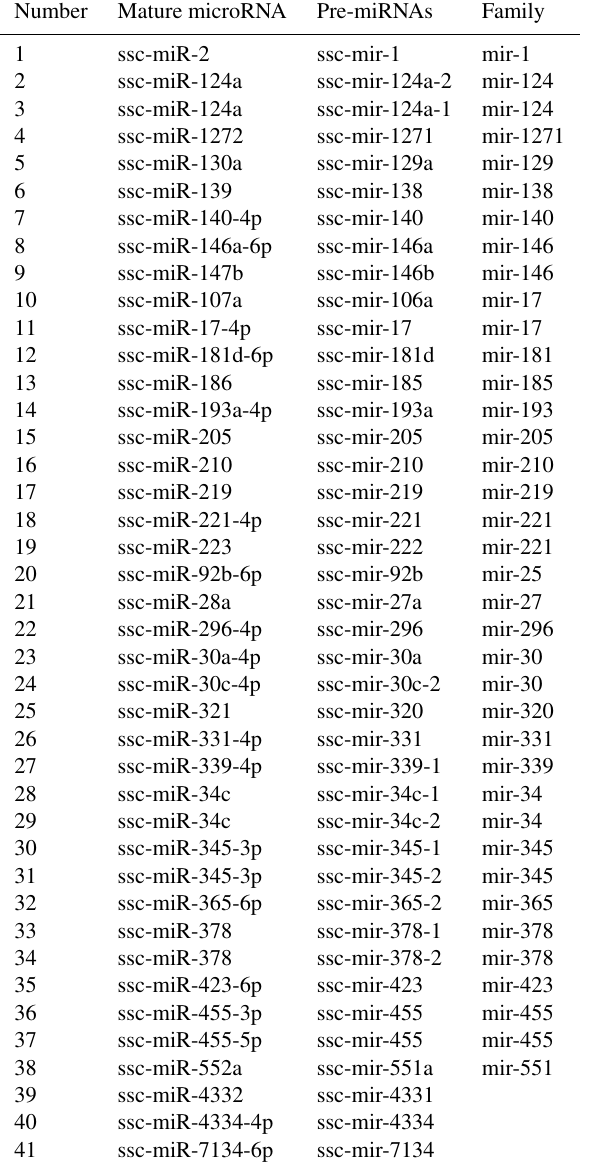
Table 3. Family analysis of upregulated miRNAs in exosomes.